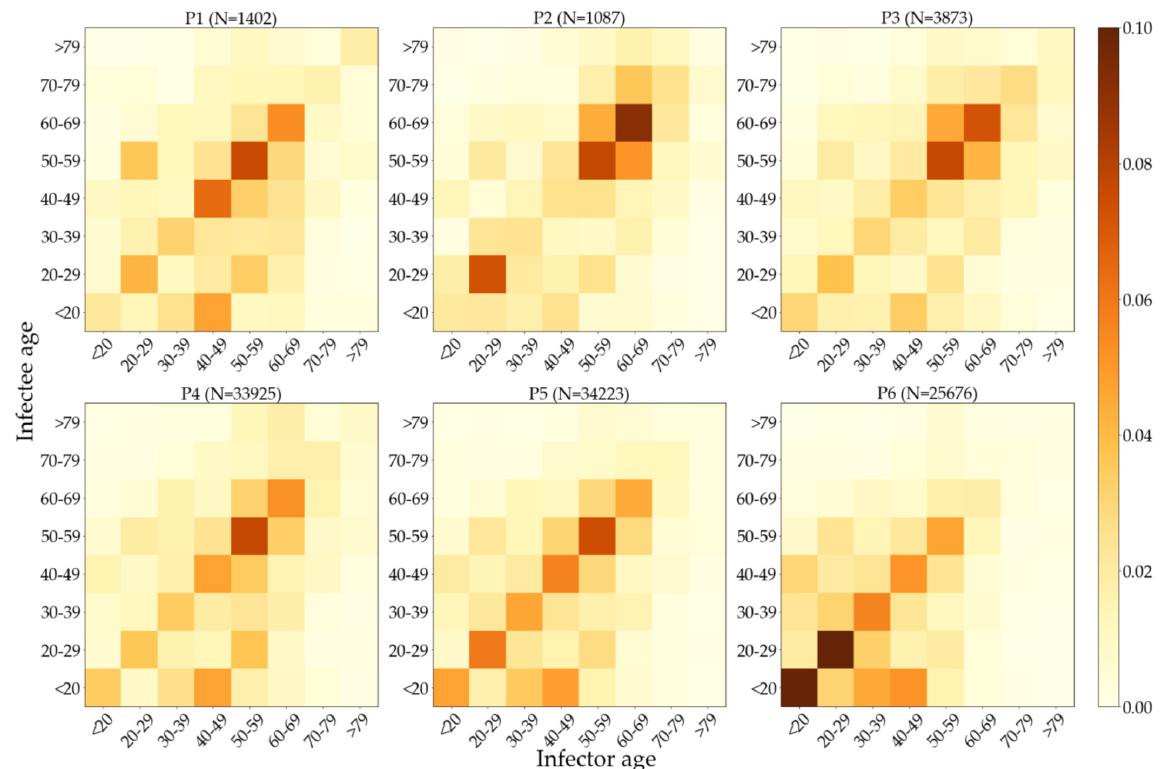
Figure 8. Heatmaps of the relative frequency of infector–infectee pairs with respect to their age.